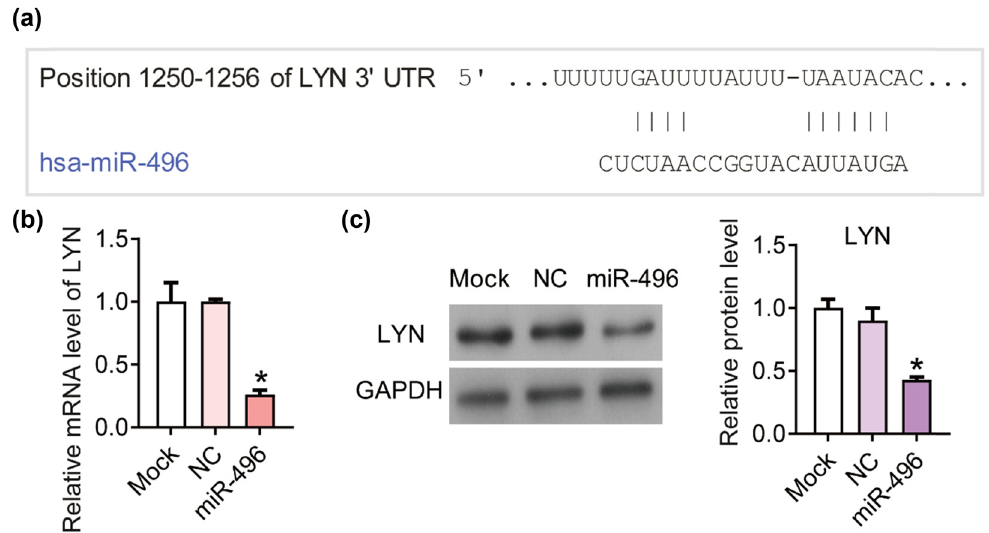
Figure 3: miR - 496 inhibited the expression of LYN in gastric cancer cells. ( a ) According to the analysis on targetScan, there was a binding site between miR - 496 and 3 ʹ - UTR of LYN. ( b ) QPCR was performed to detect the level of LYN in AGS cells transfected with miR - 496 mimics. Relative level of LYN was analyzed using 2 − ΔΔ Ct method and normalized to mock group. ( c ) The expression levels of LYN were detected by western blot. The relative protein levels were normalized to mock group. NC = negative control. * P <